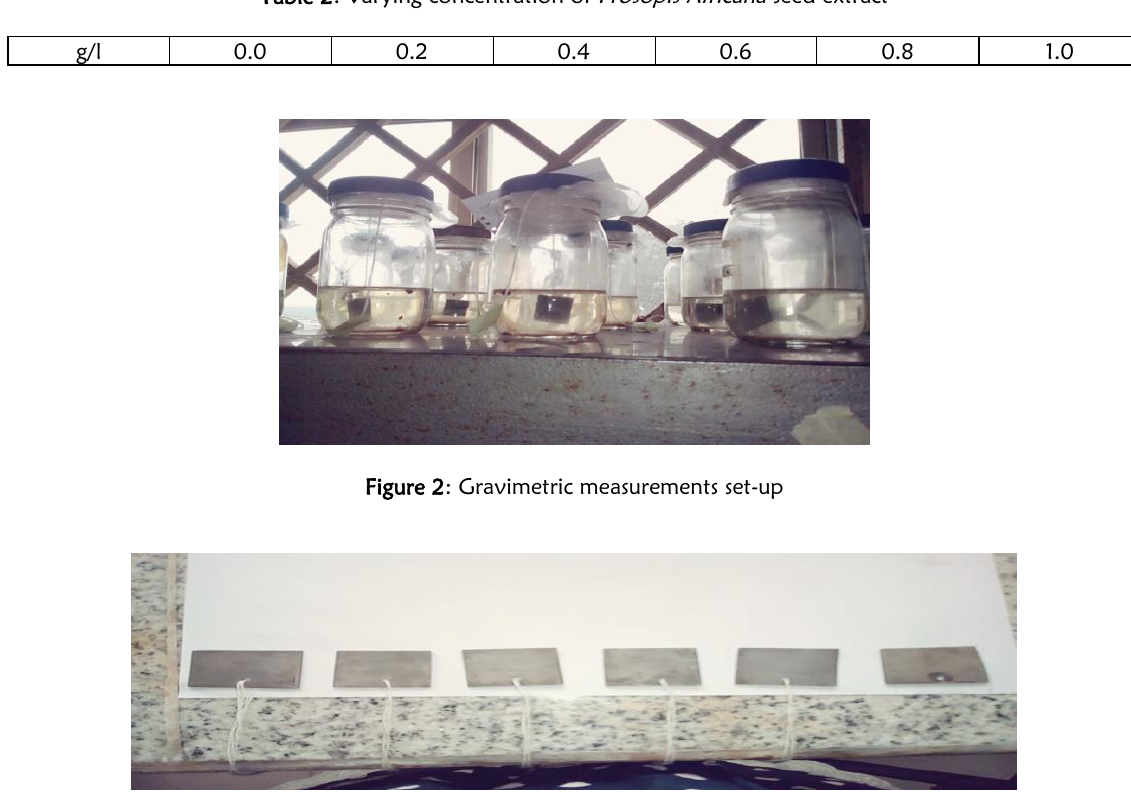
Table 2: Varying concentration of Prosopis Africana seed extract